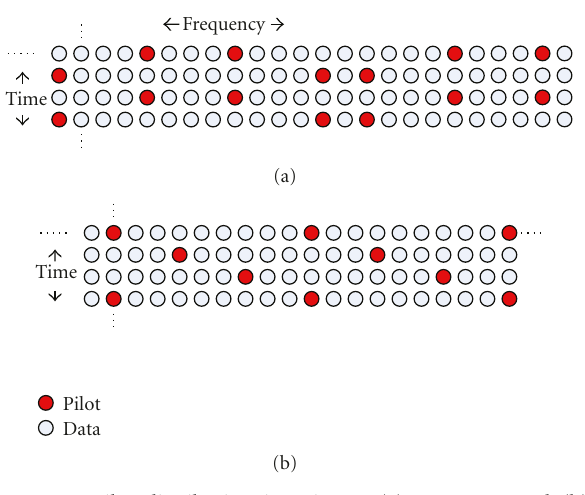
Figure 4: Pilot distribution in WiMAX (a) DL-PUSC and (b) AMC23 configurations.